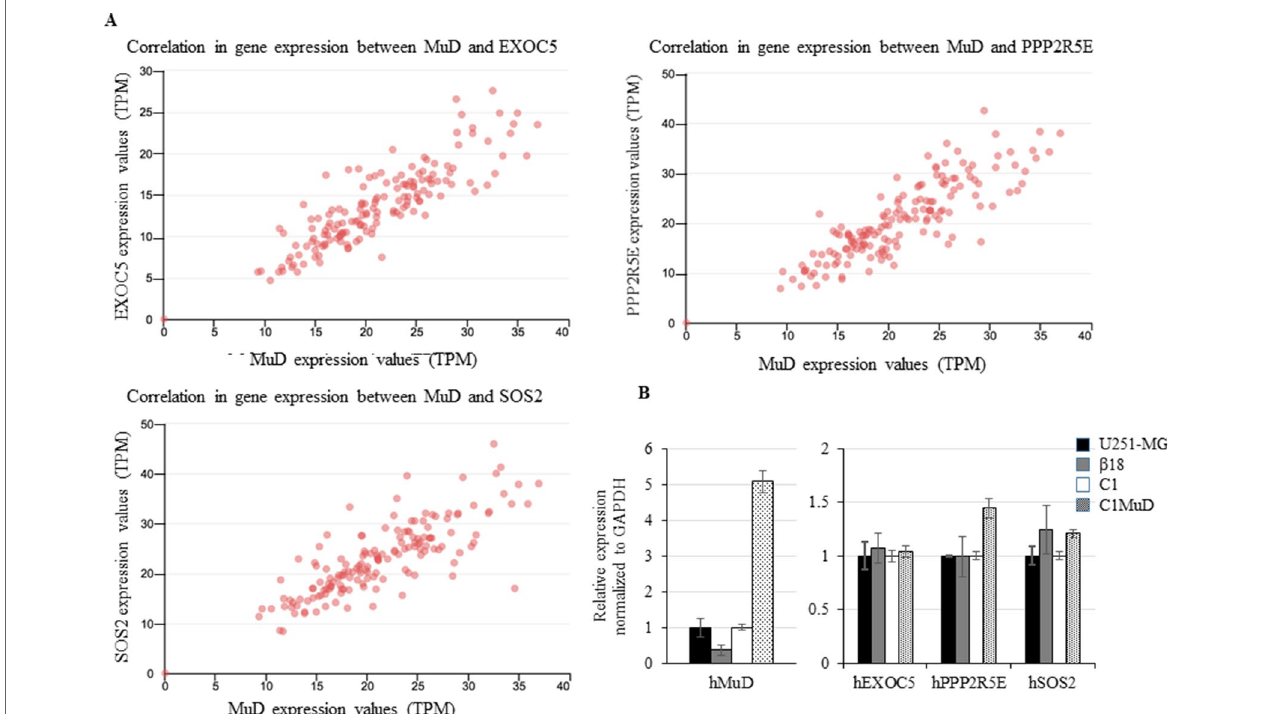
FIGURE 4 | Correlation between EXOC5 , PPP2R5E , and SOS2 expression levels and MuD levels. Expression in GBM tissues from TCGA database (A) and expression of MuD , EXOC5 , PPP2R5E , and SOS2 in the GBM MuD KO line β 18 and MuD overexpression line C1MuD as compared with that in their respective controls (B)